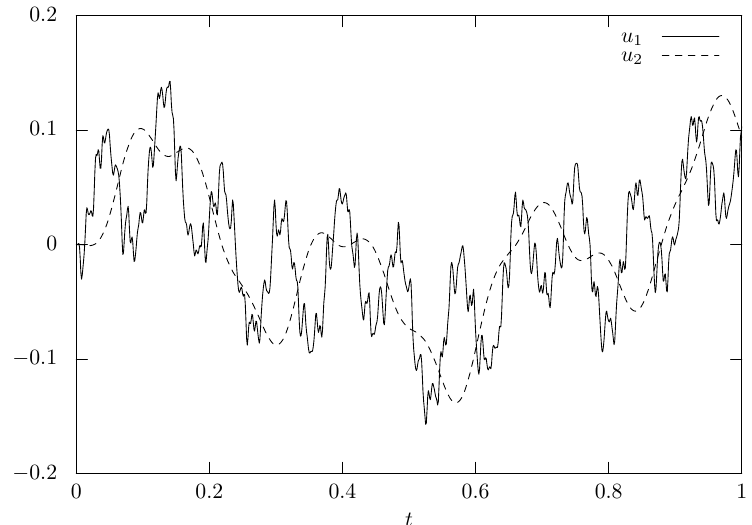
Figure 8. The computed behaviors of the both sides of the spring in Equation (96). The curve for the free side is much smoother than the other, which shows that this spring serves as a shock absorber.